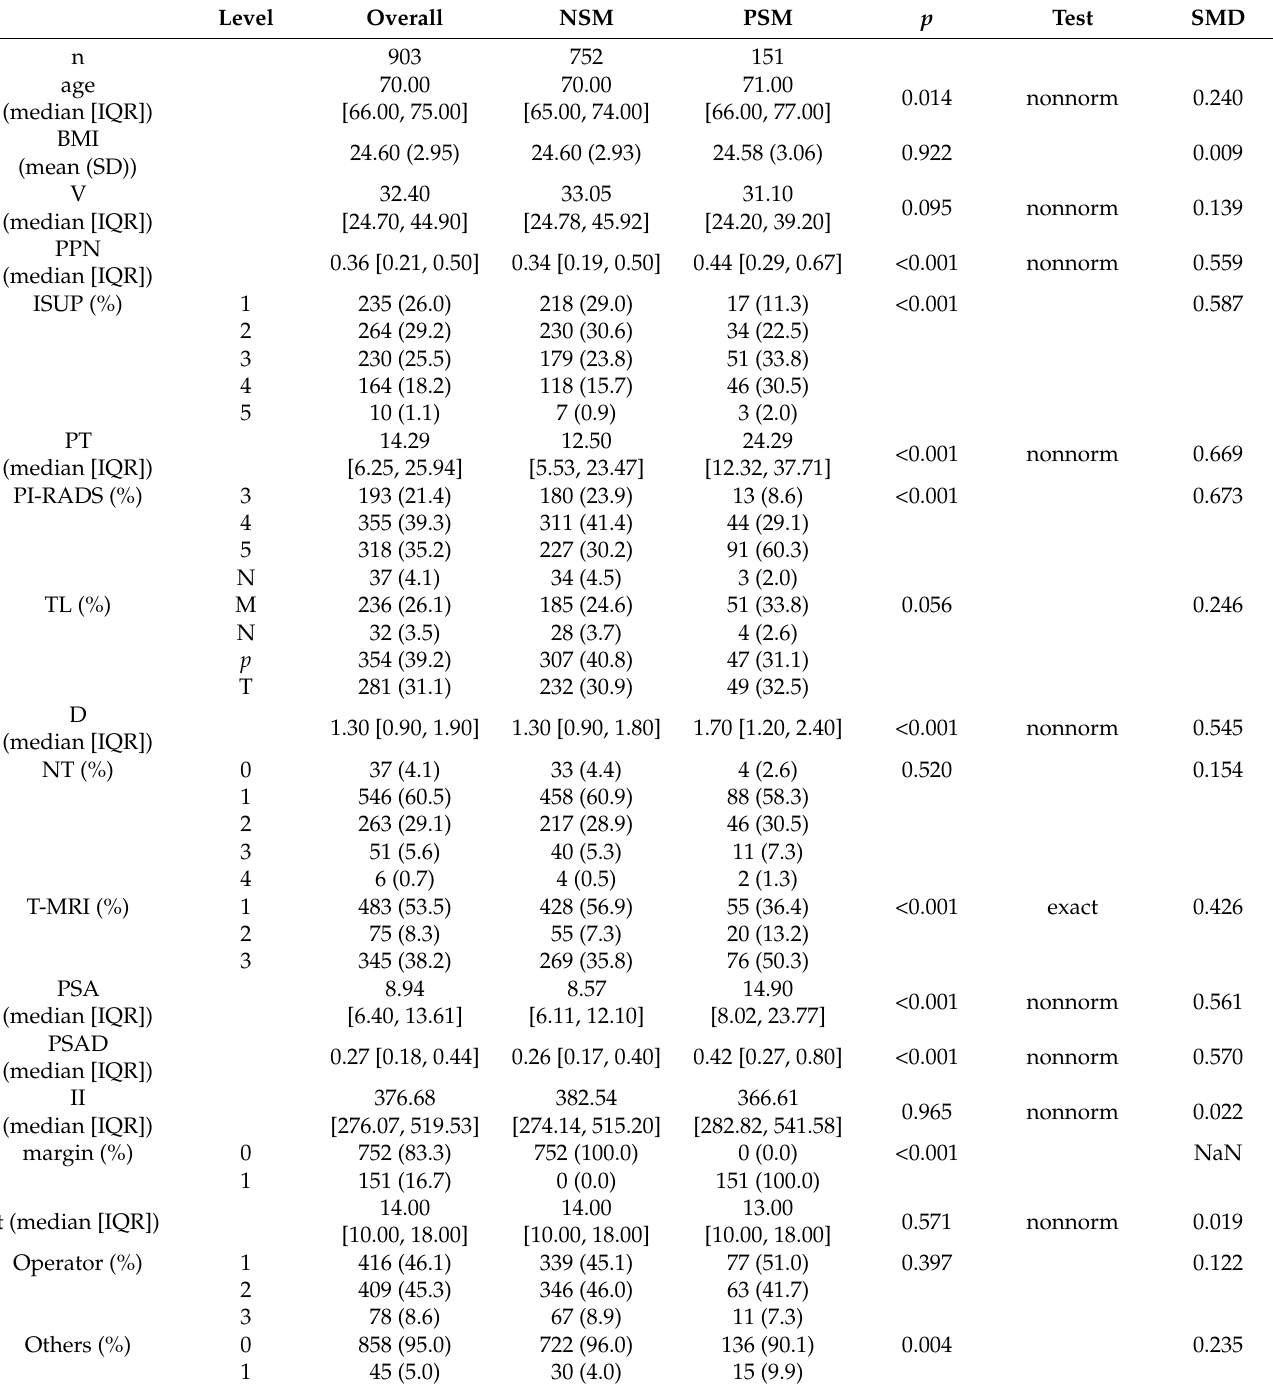
Table 1. Baseline characteristics of patients with prostate cancer. Values are numbers (percentages) of